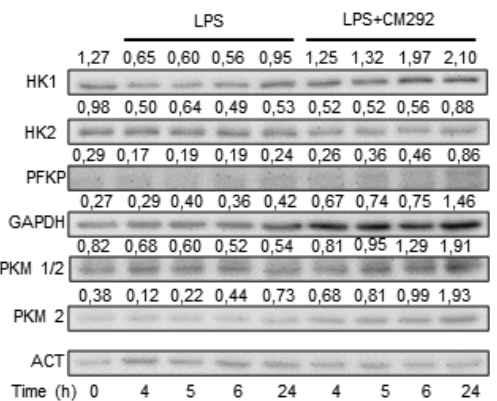
Figure 4. CM292 modulates enzyme of the glycolytic pathway. BV2 microglial cells were pre-treated with 10 μ g/mL LPS for 3h and then 200 μ M CM292 was added for further 1 h, 2 h, 3 h, and 21 h. At each time point, cells were collected and total extract used to analyze the enzyme of the glycolytic pathway by Western blotting. Β -actin was used as loading control. Numbers above the images represent the ratio between respective protein and β -actin band intensity. Images are representative of one out of three separate experiments.